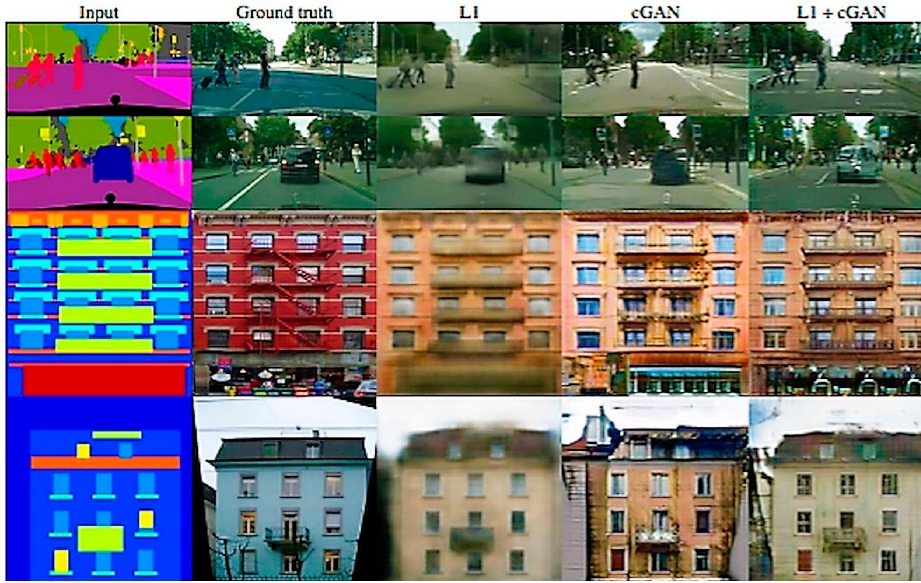
Figure 19. Comparison of losses to result of the GAN.